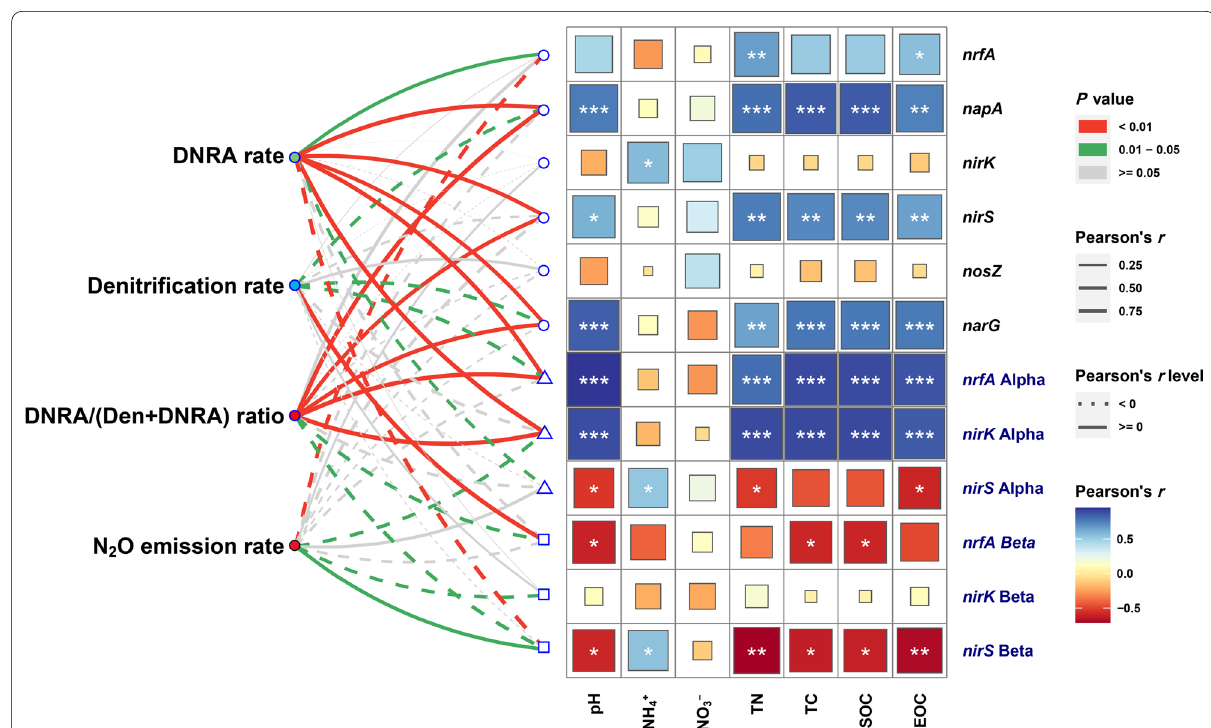
Fig. 5 Pearson correlations between abundance, alpha and beta diversity of nitrate reducers, and N transformation rates [Denitrification, DNRA, N 2 O emission, and DNRA/(Den DNRA) ratio], and soil properties in all biochar-amended treatments (Control, 0.03%BC, 0.1%BC, 0.5%BC, and + 1.0%BC treatments). The color gradient and square denote Pearson’s correlation coefficients. Asterisks indicate statistical significance with significance levels of * P 0.05, ** P 0.005, and *** P 0.001 for P values. The abundance and diversity of related microbes were related to each ≤ ≤ ≤ physicochemical property and N transformation rate by Pearson’s correlation test. Red, green, and gray edges indicate significant at P < 0.01, P < 0.05, and nonsignificant relationships ( P 0.05), respectively. Solid and dashed lines indicate positive and negative relationships, and the thickness of the ≥ line denotes Pearson’s correlation coefficients. The alpha and beta diversity of related microbes encoded by different genes were represented by the corresponding Shannon index and Bray–Curtis dissimilarity,